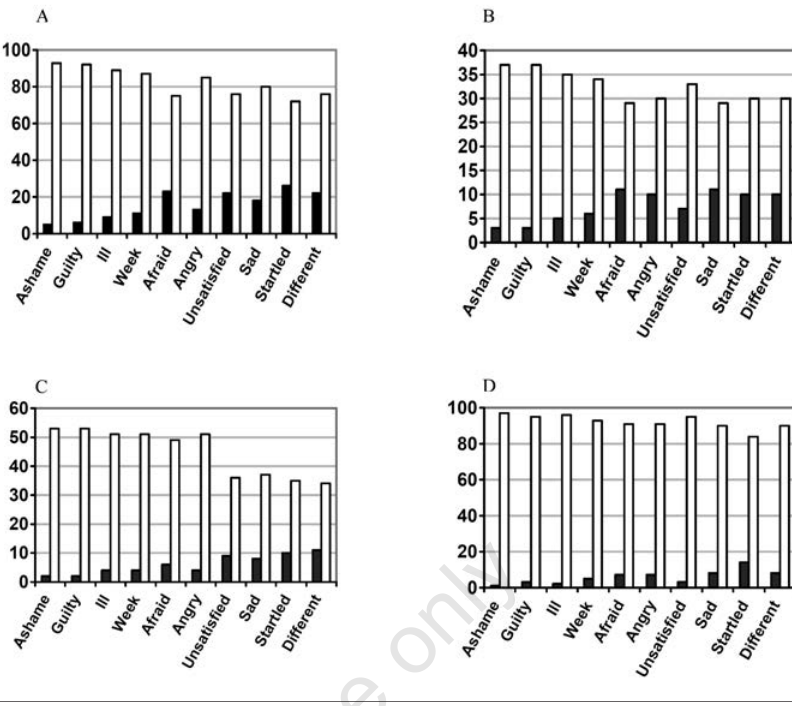
Figure 4. A) Negative (black) versus positive feelings (white) measured in the total cohort at level 1 when learning the diagnostic results for the first time with or without explana- tion. Negative feeling rate 17.9%. B) Negative (black) versus positive feelings (white) measured at level 1 in the cohort who had no letter and no explanation when learning the diagnostic results for the first time by. Negative feeling rate 23.4%. C) Negative and pos- itive feelings measured in the cohort that had both letter and explanation at level 1.